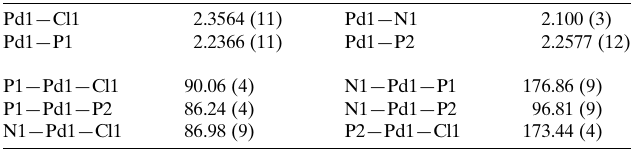
Table 1 Selected geometric parameters (A˚ , (cid:4) ).